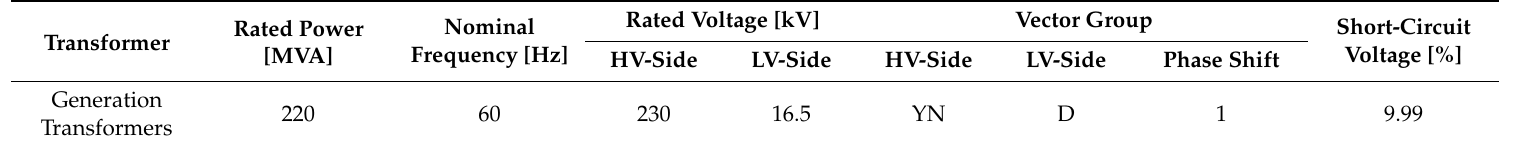
Table A1. Electrical parameters for the generation transformers used in the STS.